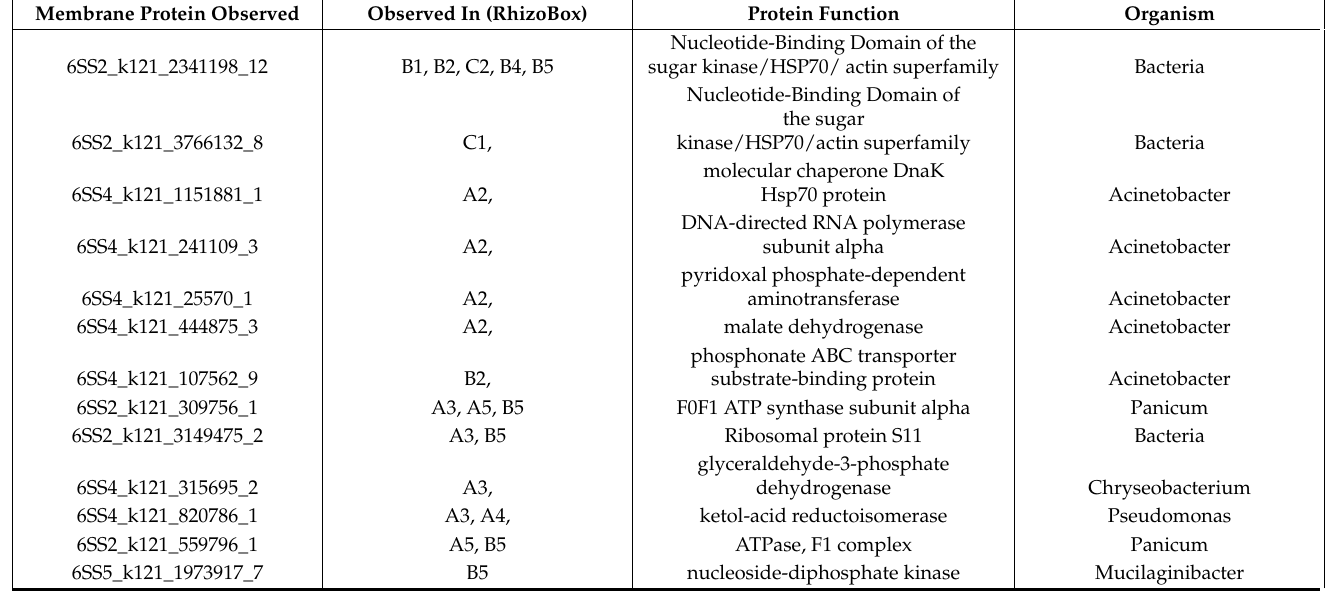
Table 1. Protein identifications from the ‘rhizobox’ samples blots. Functions and taxonomic are from RefSeq notation. Membrane Protein Observed Observed In